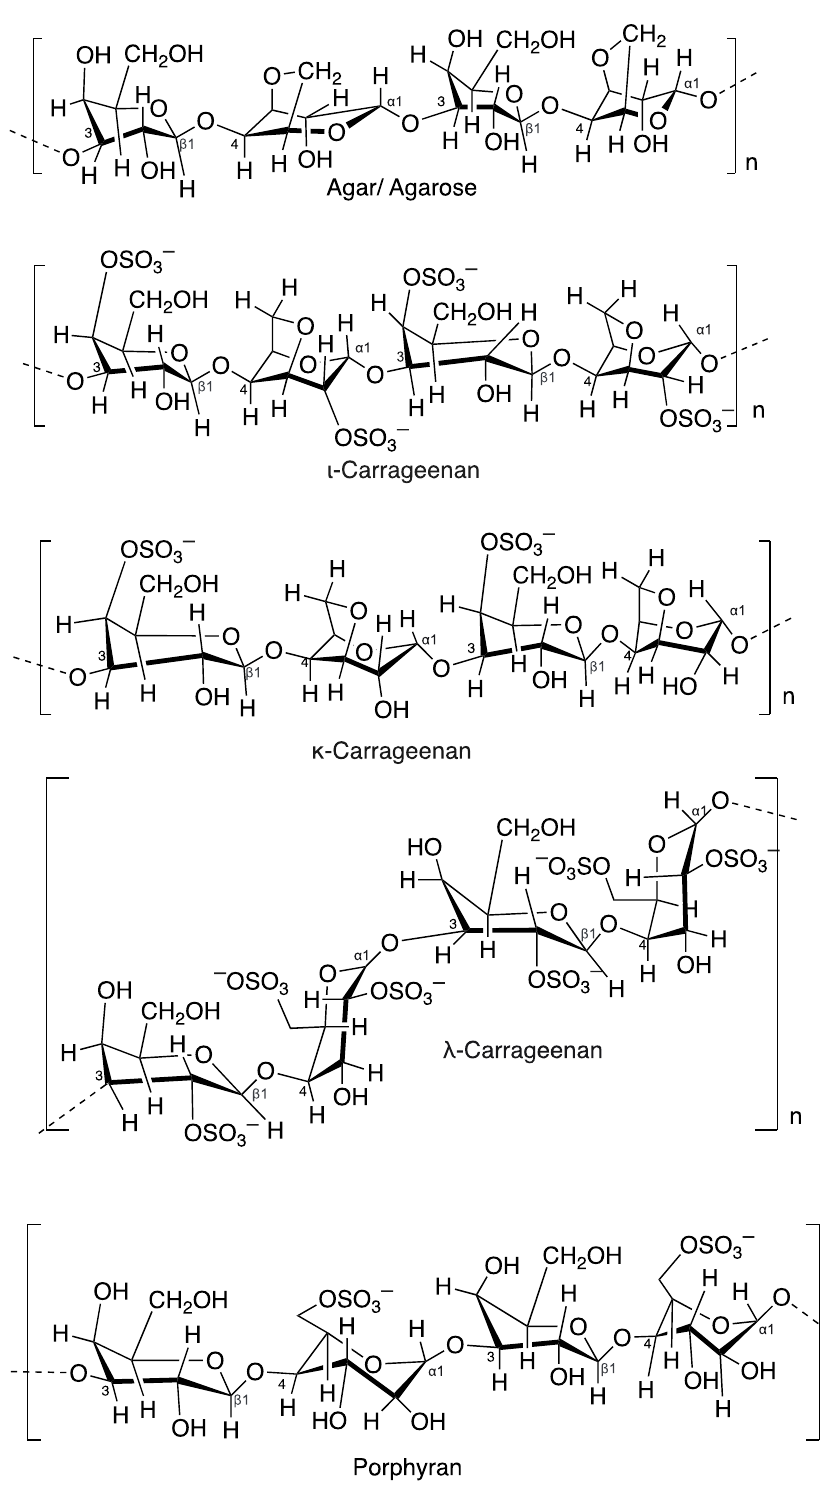
Figure 8. Chemical structures of agar, iota carrageenan, kappa carrageenan, lambda carrageenan and porphyran.